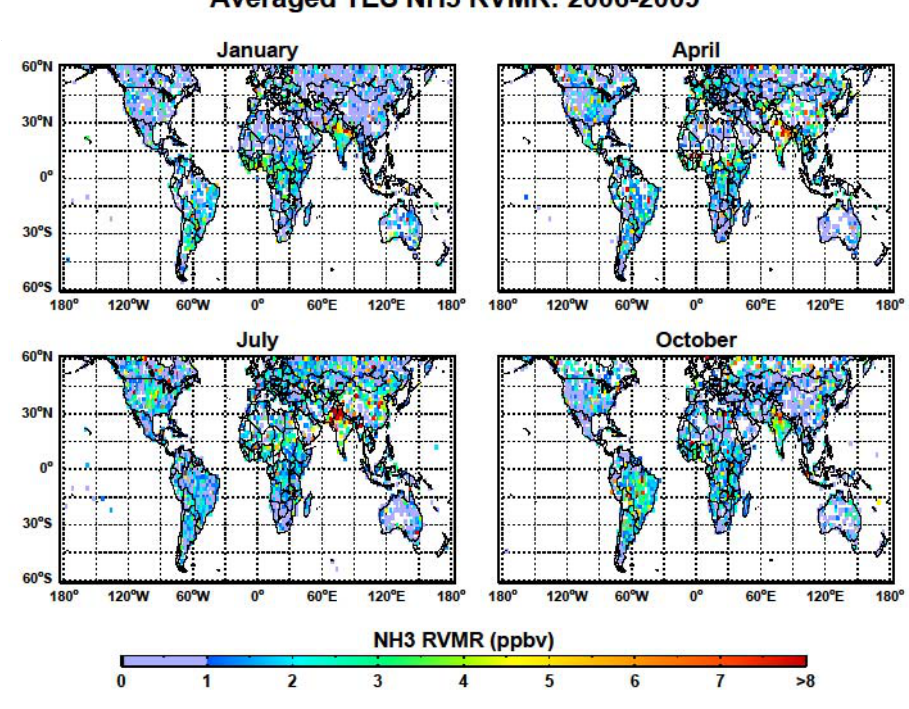
Fig. 11. TES RVMR averaged over 2 × 2.5 degree boxes. The white grid boxes over land are just regions without a valid TES RVMR. In Figure 3: TES RVMR averaged over 2 x 2.5 degree boxes. The white grid this study we did not analyze observations over the ocean. boxes over land are just regions without a valid TES RVMR. In this study we did not analyze observations over the ocean.